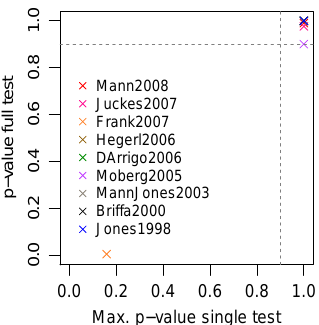
Fig. B2. The Northern Hemisphere reconstruction sub-ensemble re-calibrated to 1920–1960 (FRS): test for consistency of the remaining members of the ensemble against a target defined by one of the members: p values for the full goodness-of-fit χ 2 test plotted against the maximum of the p values obtained from the tests for bias and spread deviations. Note that the results cluster in the top-right corner of the panel for five of the possible targets. Uncertainty inflation was chosen to be proportional to the full ensemble spread. Results change if we consider only sub-ensemble spread but conclusions remain